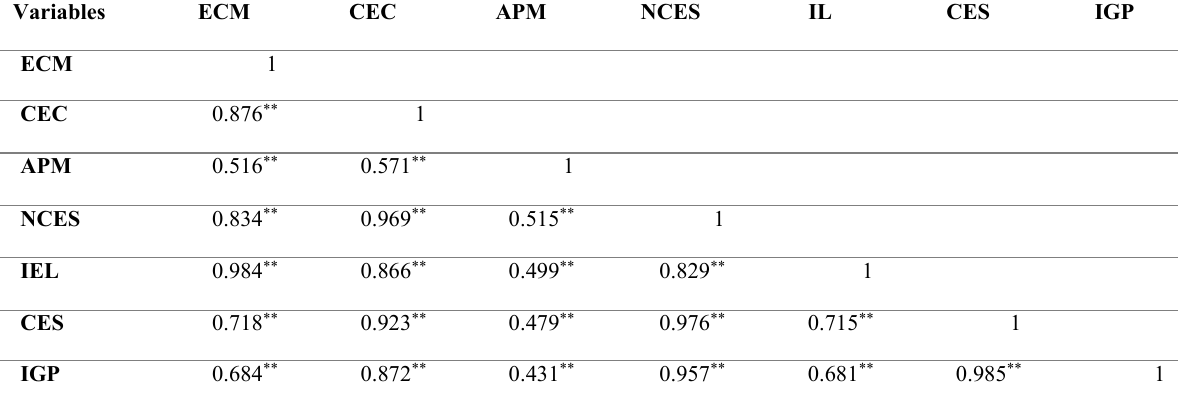
Table 2: Correlation Coefficient (the value of r) for